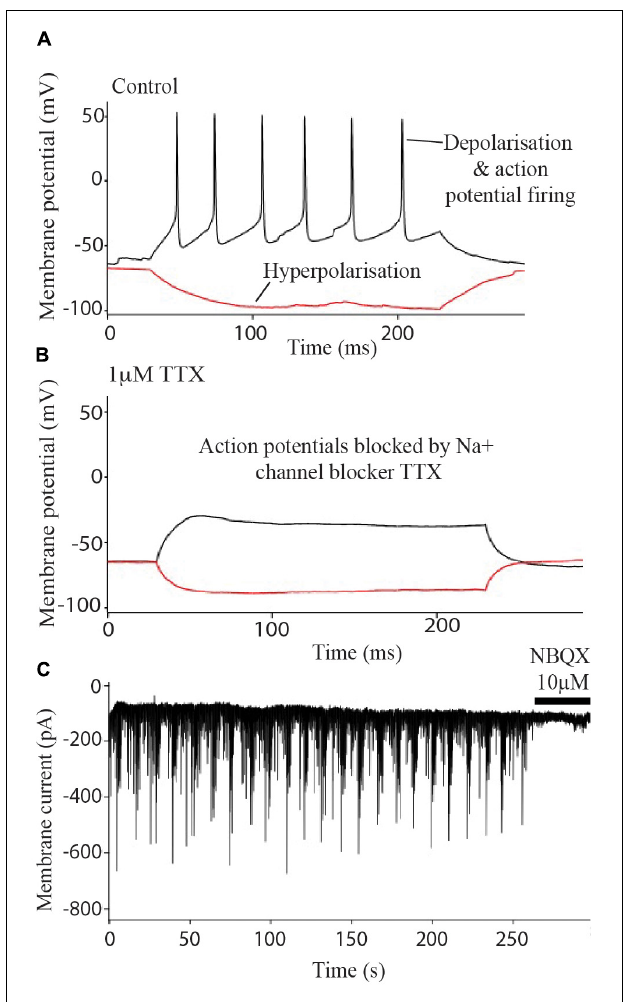
FIGURE 2 | Electrophysiology of iPSC derived neurons. Neurons fire action potentials (A) which are blocked after the addition of 1 µ m TTX (B) . Excitatory post synaptic currents (C) are abolished after treatment with 10 µ M